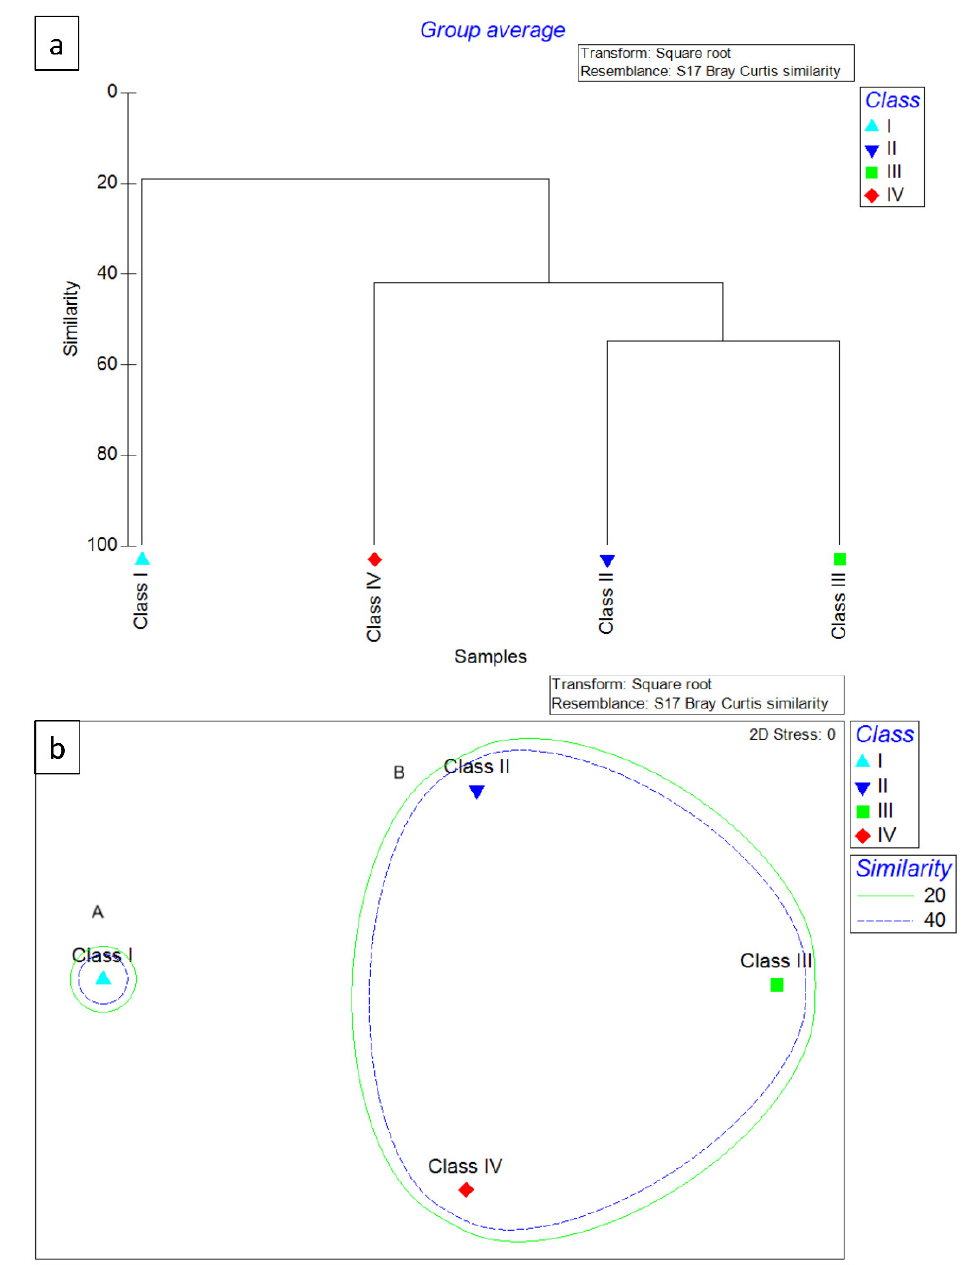
Figure 3. Dendrogram ( a ) and MDS ordination of Bray–Curtis similarities ( b ) from dietary data (square root transformation) for the 4 hake ontogenetic stages analyzed in 2018. Cluster A included only the specimens belonging to Class I, while Cluster B included the specimens belonging to Classes II–IV Table 4. Results of the SIMPER analysis conducted between European hake trophic groups from 2018. The average similarity between cluster groups is reported. The percentage and cumulative contribution of typifying species within-group similarity of the identified hake trophic groups is shown. The table shows results obtained for the trophic cluster B, which includes Classes II–IV. Trophic cluster A = less than 2 size groups.